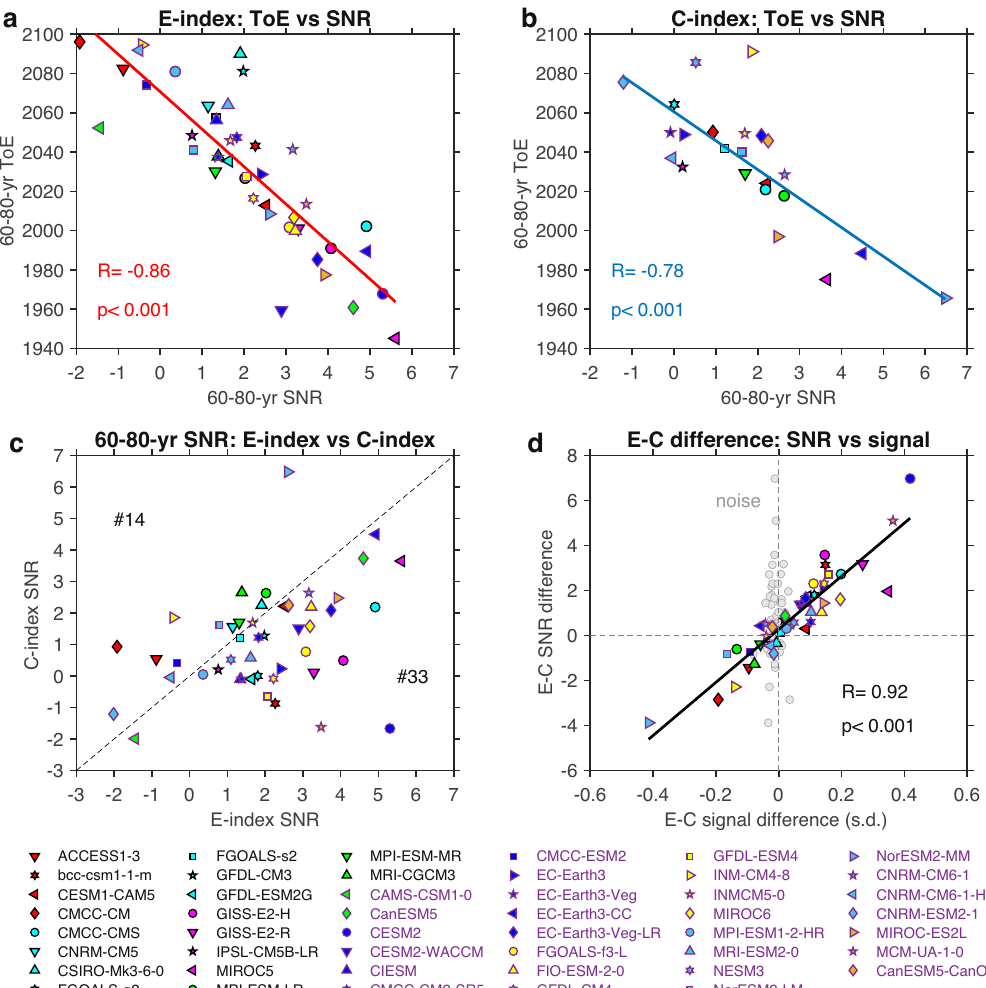
Fig. 3 | El Niño-Southern Oscillation (ENSO) time of emergence (ToE) deter- mined by magnitude of sea surface temperature (SST) variability change. a , b Inter-model relationship between ToE and Signal-to-Noise-Ratio (SNR) in models (symbols; name of CMIP5 models in black, name of CMIP6 models in purple)thatshowToEbefore2100for a E-indexand b C-index. c ContrastofSNR betweenE-index( X -axis) and C-index( Y -axis). Numberon the top left, orbottom right, indicatesthenumberofmodelsshowinglargerSNRofC-index,orE-index, respectively. d Inter-model relationship between E-minus-C difference of signal